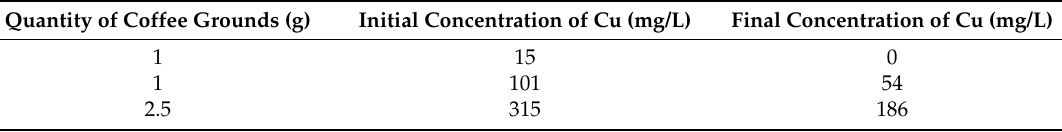
Table 2. The biosorption of copper using functionalized coffee grounds. 1